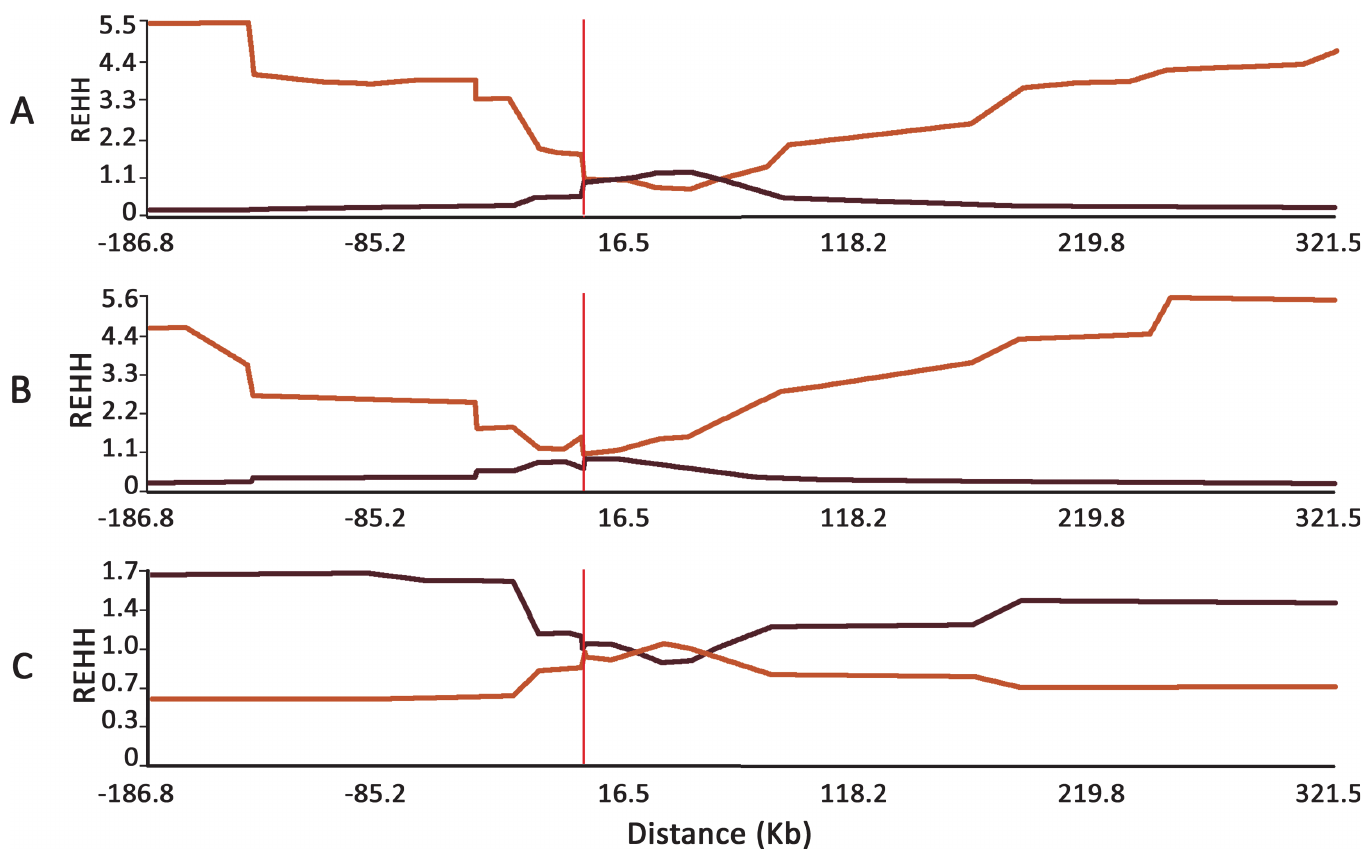
Fig 2. Relative extended haplotype homozygosity (REHH) for 30 SNPs located at a distance described in the X-axis from ACTN3 rs1815739 spanning circa 510 kb. The orange line represents the homozygosity of the flanking SNPs relative to rs1815739 for haplotypes carrying the derived 577X allele, while the red line represents the same for haplotypes carrying the ancestral allele ( i.e . for Asia, REHH indicates that extended haplotype homozygosity-EHH, considering 577X -bearing chromosomes, is about 5.5 times greater than the average EHH of the others bearing R577 ). A: Asian; B: European; and C: American